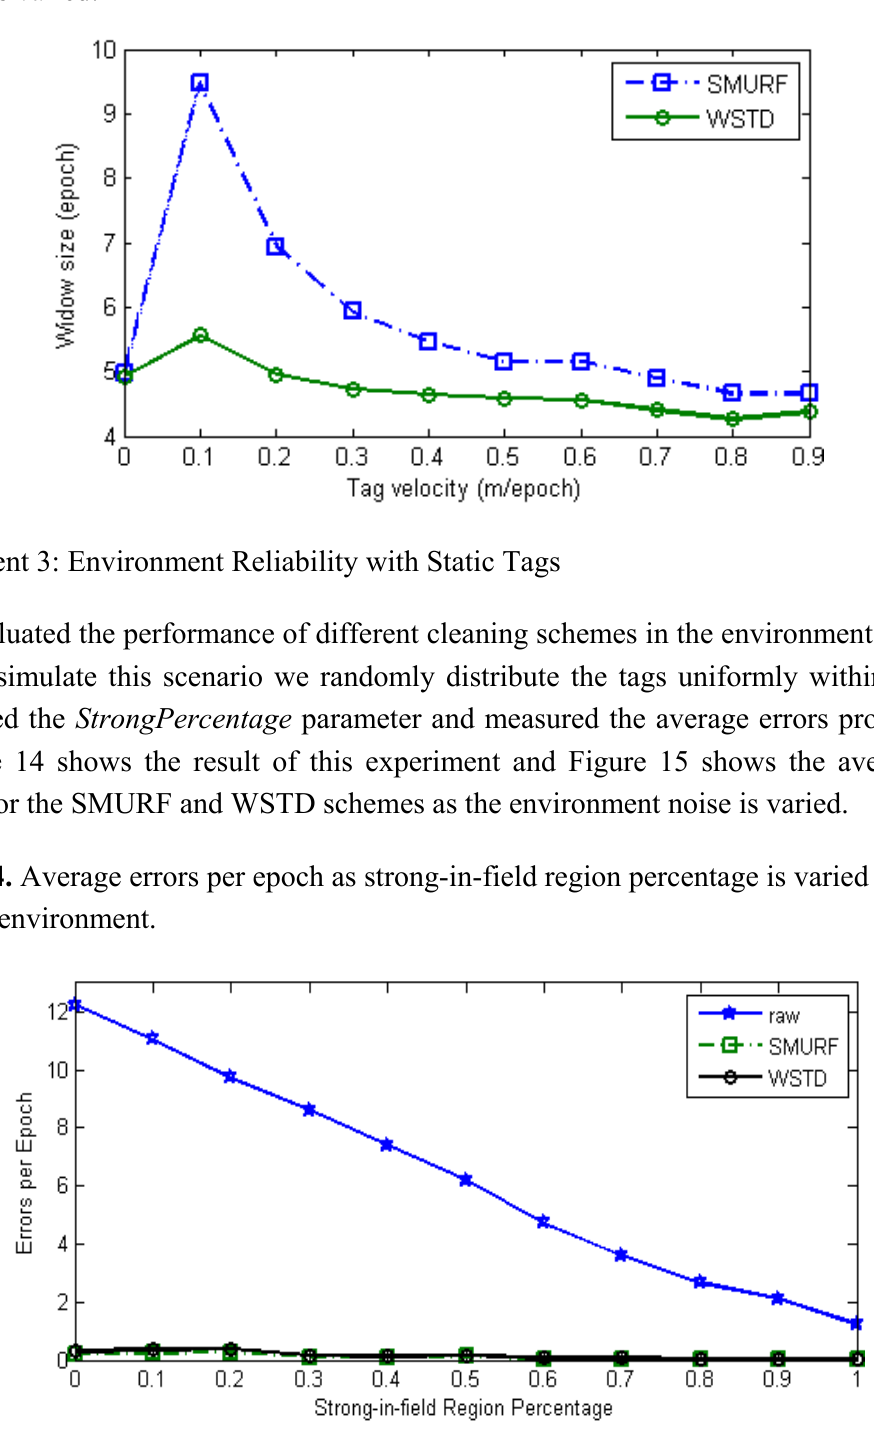
Figure 13. Comparison of WSTD and SMURF schemes’ cleaning window sizes as the velocity is varied.